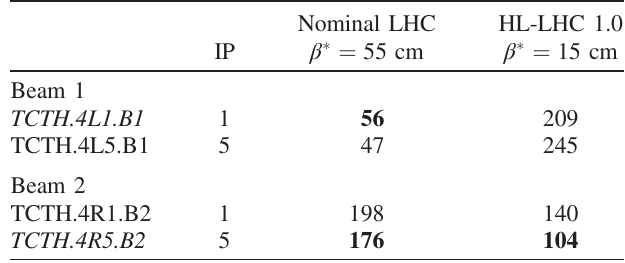
TABLE II. Betatron phase advances (module expressed in 360 degrees) between MKDs and horizontal TCTs in front of the high-luminosity experiments (ATLAS in IP1 and CMS